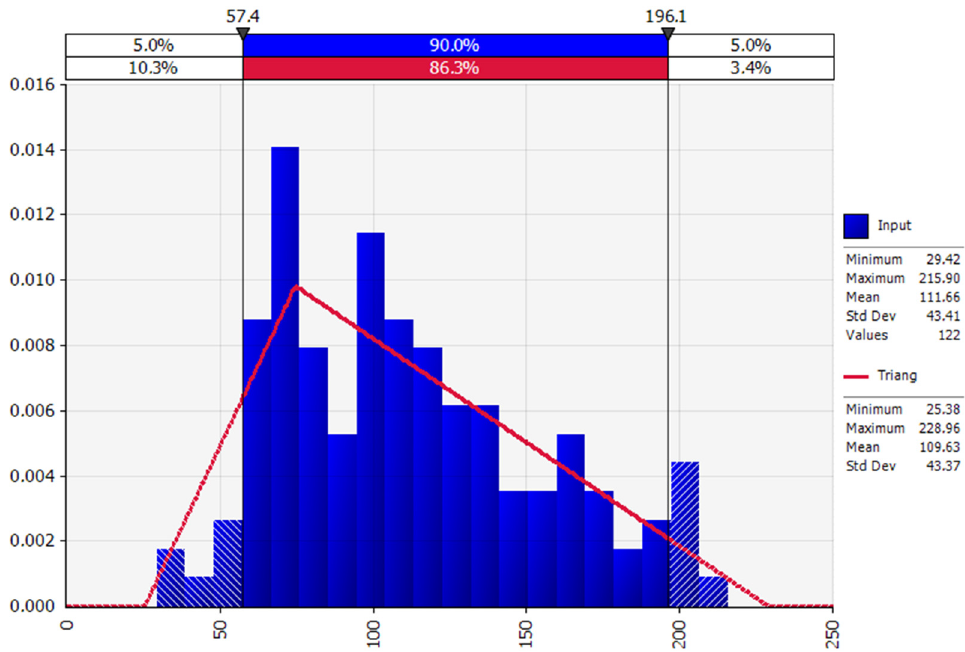
Figure 4. Coking coal prices fitting distribution in $/t.